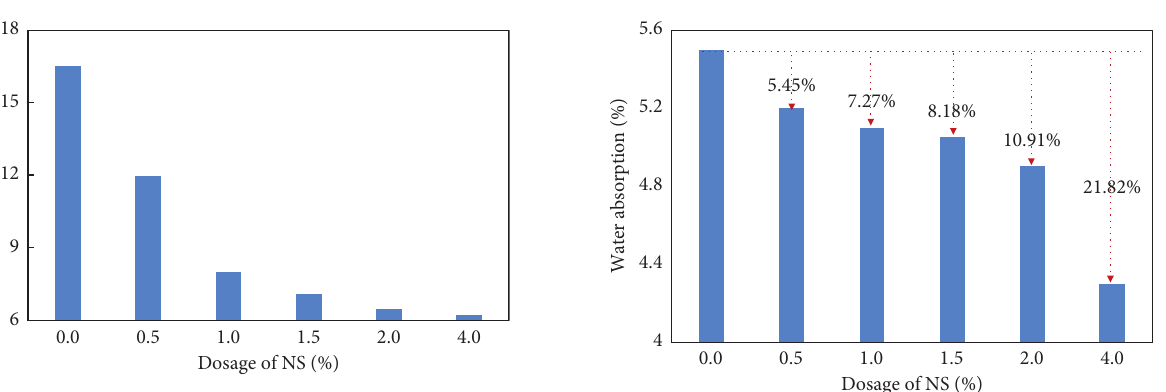
Figure 3: Effect of NS on chloride diffusion coefficient of the C-FA- NS system.